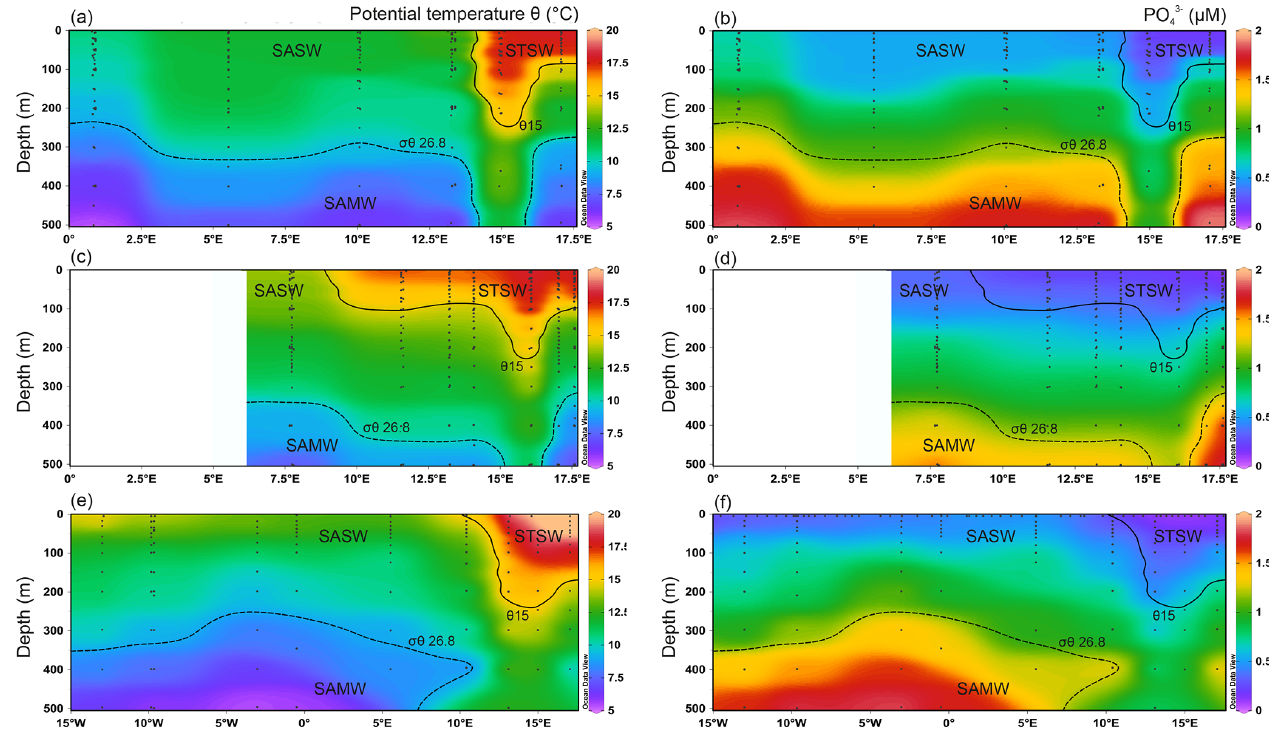
Figure 2. Upper 500m potential temperature ( θ ) and dissolved PO 3 − distributions for the south-eastern Atlantic along early-spring ( a, b ; 4 D357-1), late-spring ( c, d ; D357-2) and summer ( e, f ; JC068) transects. The dominant Southern Ocean (SASW and SAMW) and South Atlantic (STSW) water masses that influence the distribution of nutrients are shown. The θ 15 ◦ C isotherm (solid contour) represents a practical definition of the STF location, whilst SAMW is identified by the median-potential-density ( σθ ) isopycnal (26.8kgm − 3 ; dashed contour; see Sect. 4.1.). STSW: sub-tropical surface water; SAMW: sub-Antarctic mode water; AAIW: Antarctic intermediate water.